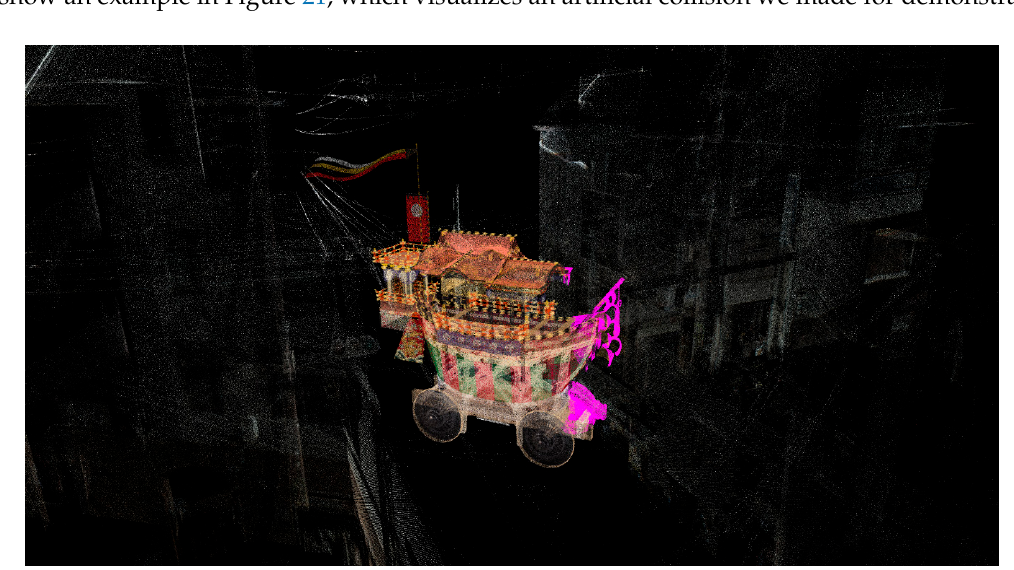
Figure 21. An example of visualizing a deep collision. Part of the Ofune-hoko float is inside the building.